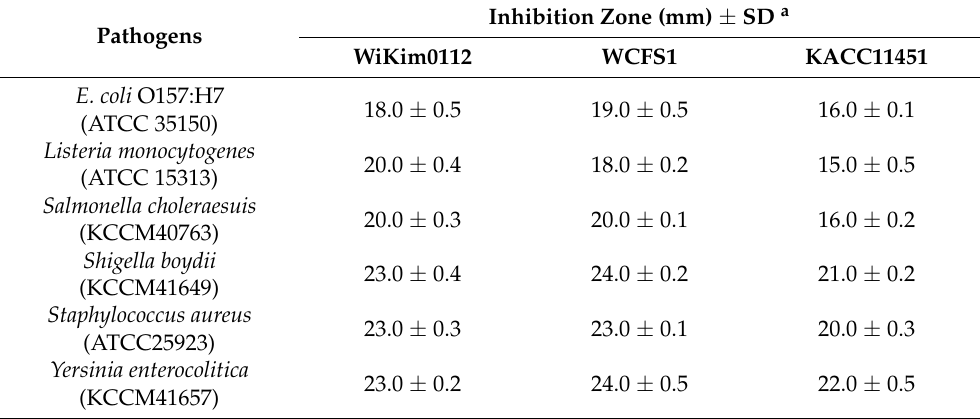
Table 2. Antibacterial activity of Lpb. plantarum Wikim0112, WCFS1, and KACC11451 against foodborne bacterial pathogens.